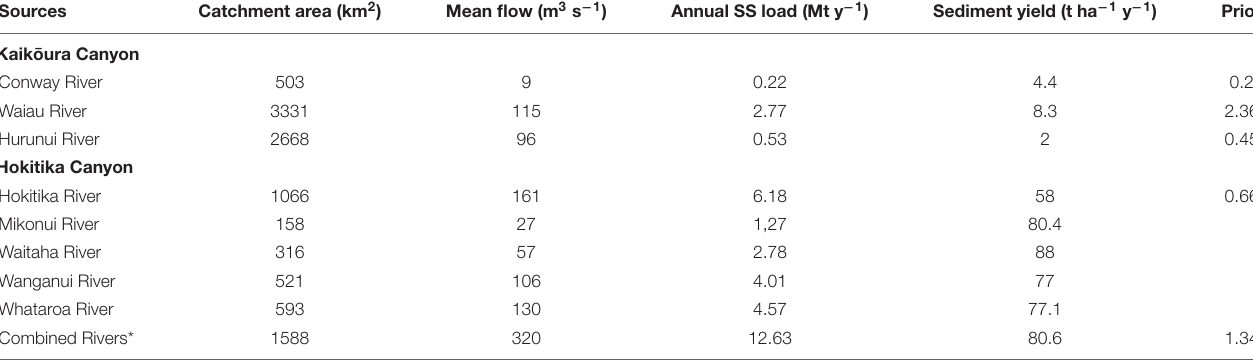
TABLE 3 | Comparison data for the west coast and east coast South Island rivers, extracted from the New Zealand River Maps database (Booker and Whitehead, 2017).